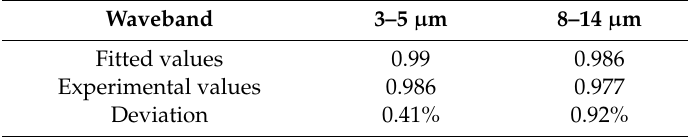
Table 5. Experimental values and fitted values of spinel materials.